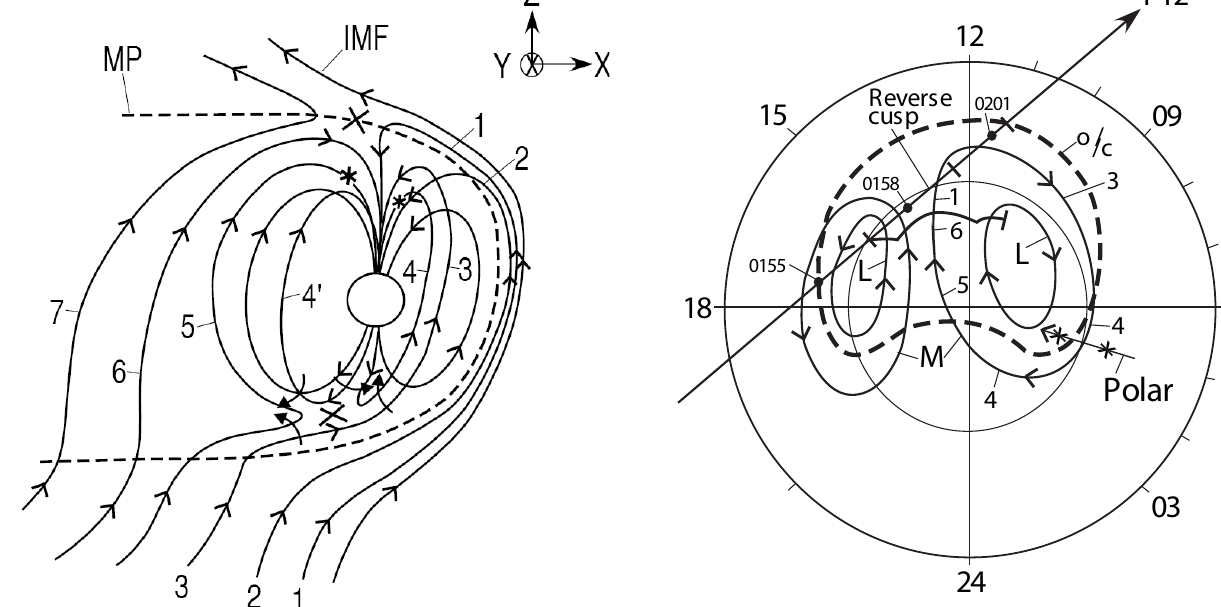
Fig. 1. Schematic illustration of magnetospheric magnetic flux cycle involving (i) high-latitude (lobe) reconnection in the north, (ii) overdraped lobe flux and (iii) internal reconnection between the overdraped lobe flux and closed geomagnetic field lines in the south at the dawn side during strongly north IMF orientation (the IMF B x < 0 case). The perspective is from the dawn side of the magneto- sphere. Positions (at two times) of spacecraft Polar at mid-altitudes on the dawn side in relation to the field line topology are indicated by stars. Adapted after Watanabe et al. (2006). Not to scale.